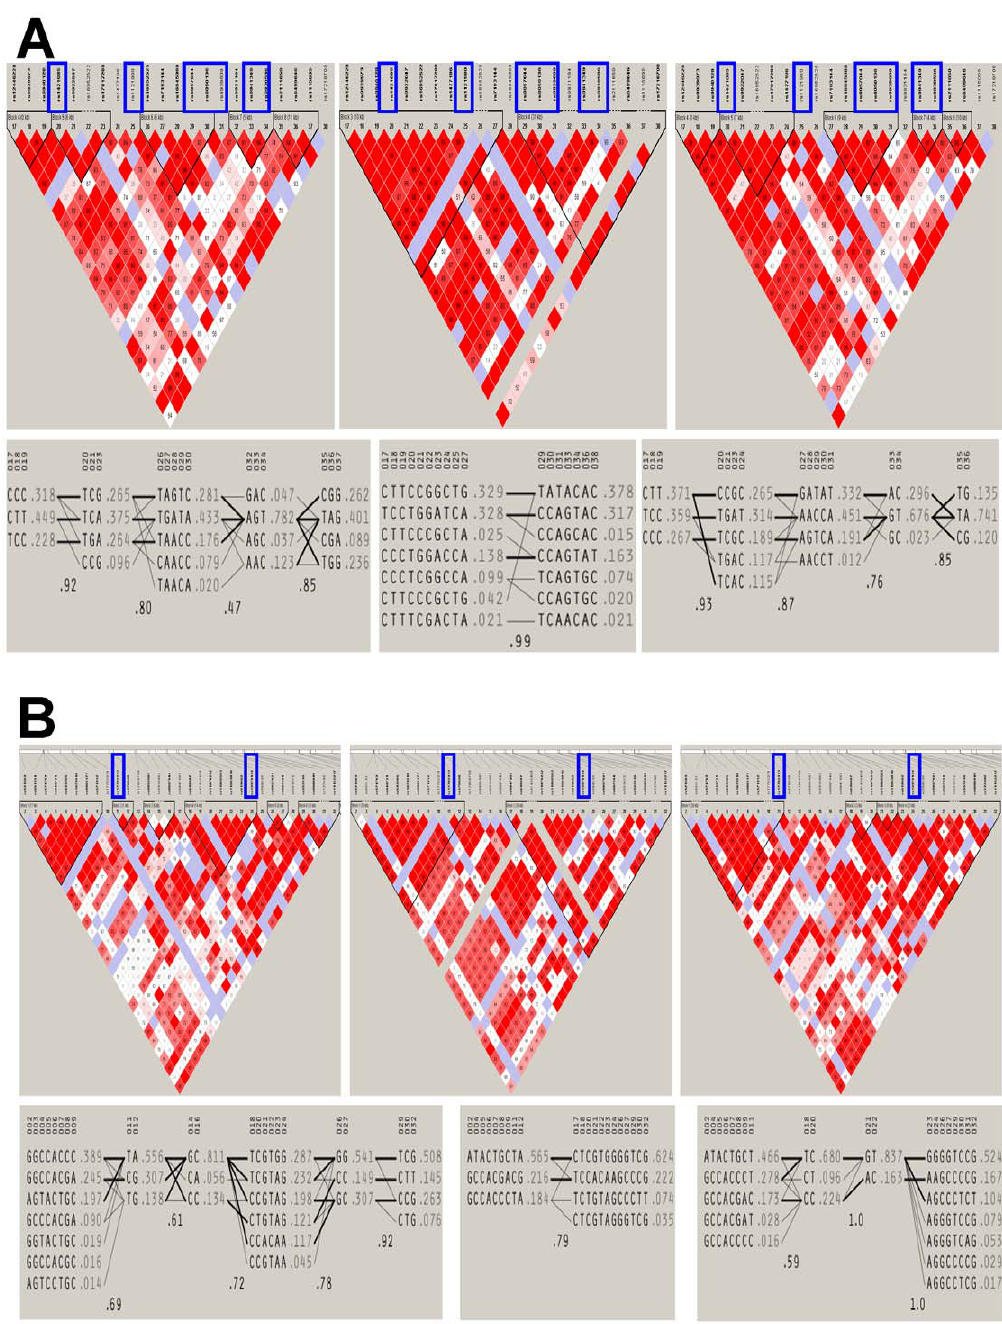
Figure 5. a: Linkage disequilibrium structure (Top) and organization of haplotypes harboring published obesity variants (rsIDs indicated with blue boxes) in FTO gene in biobank sample of African Americans (left column), European Americans (middle column), and Hispanic Americans (right column). b: Linkage disequilibrium structure (Top) and organization of haplotypes harboring published obesity variants (rsIDs indicated with blue boxes) in MC4R gene in biobank sample of African Americans (left column), European Americans (middle column), and Hispanic Americans (right column).